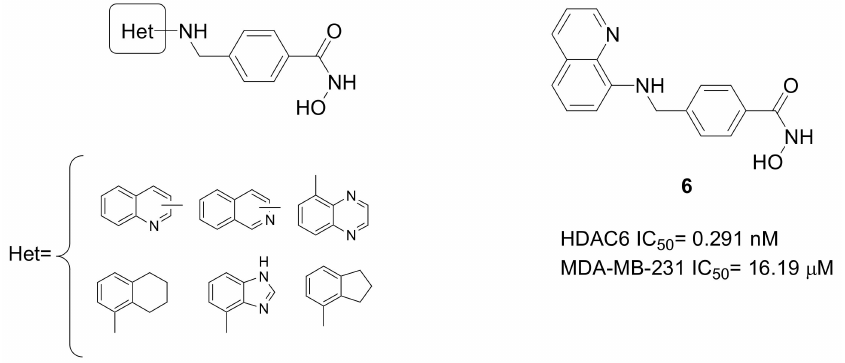
Figure 7. Chemical structures of quinoline-derivatives as selective HDAC6 inhibitors directed against